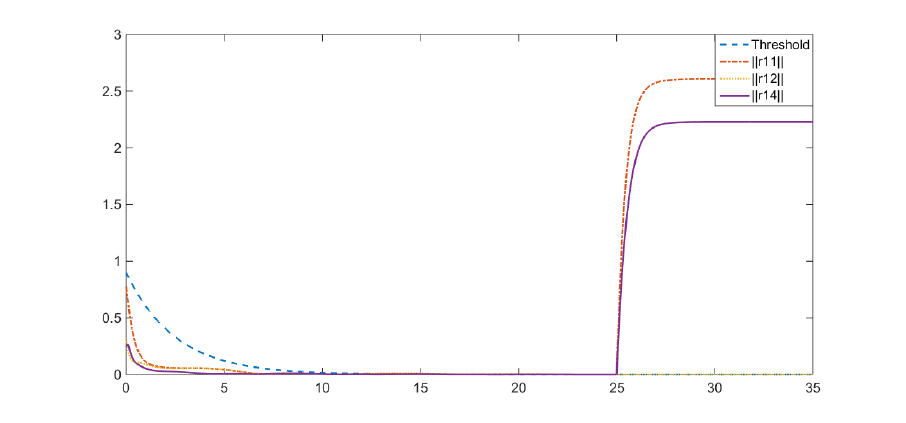
Figure 2. Residual generators in agent 1 under state